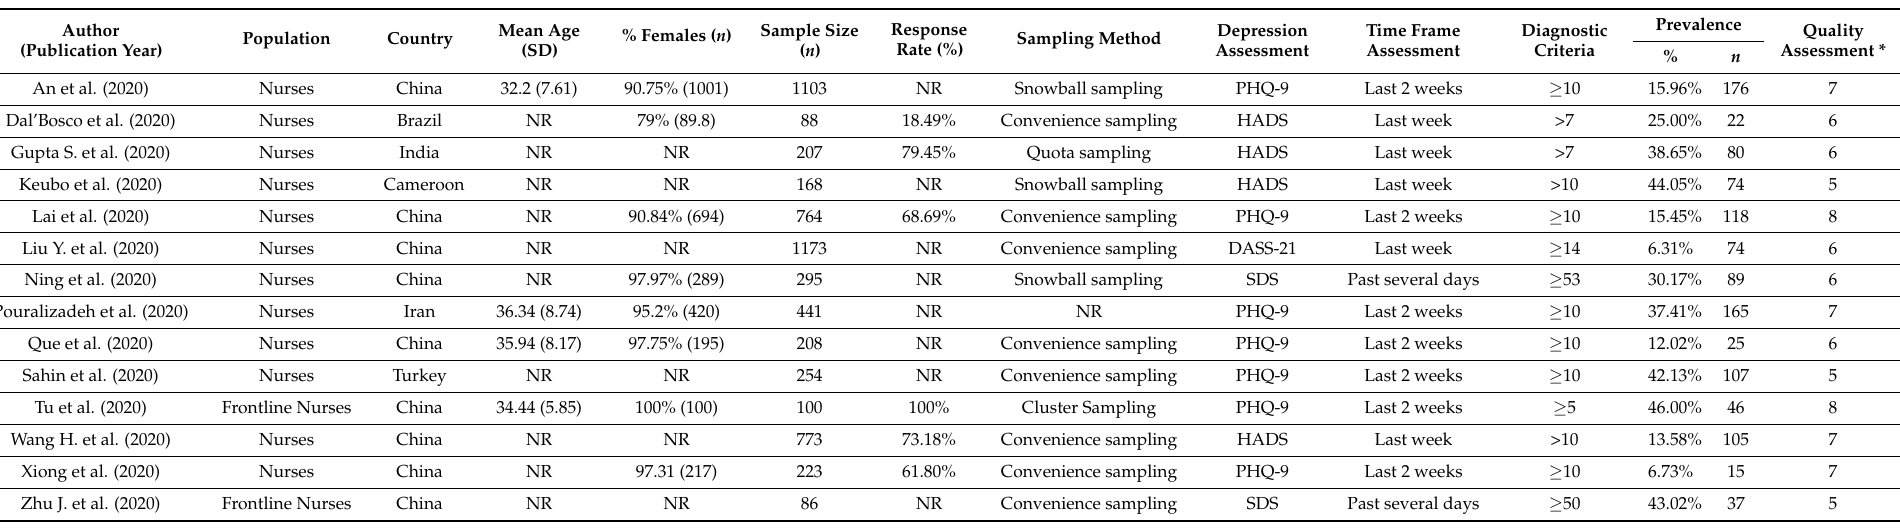
Table 2. Characteristics of the studies included in the meta-analysis based on samples of